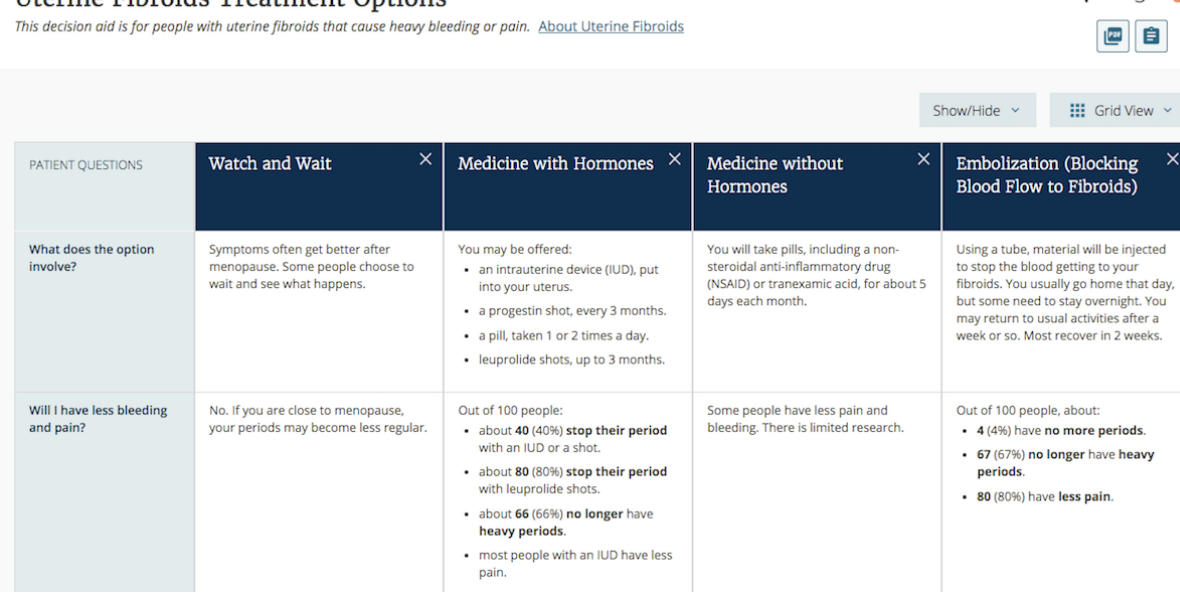
Does the clinical champion have experience